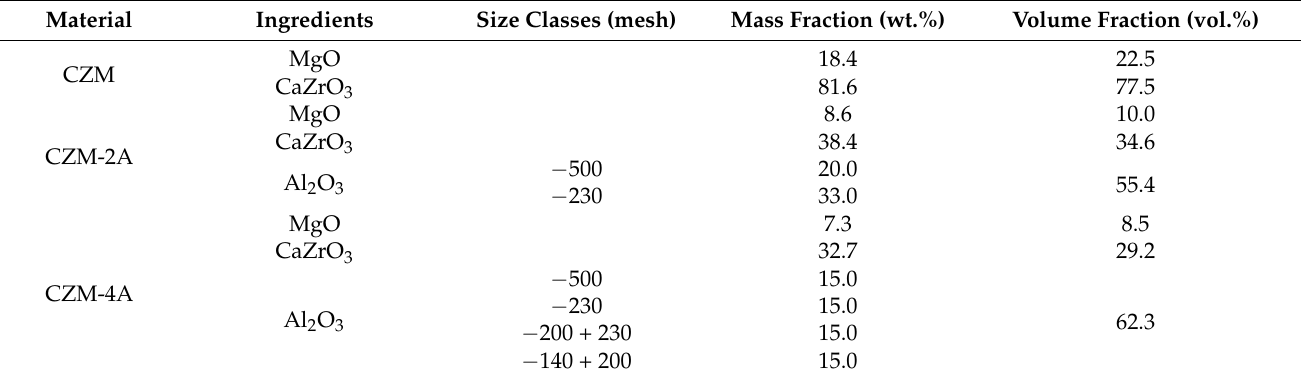
Table 1. Composition of the three